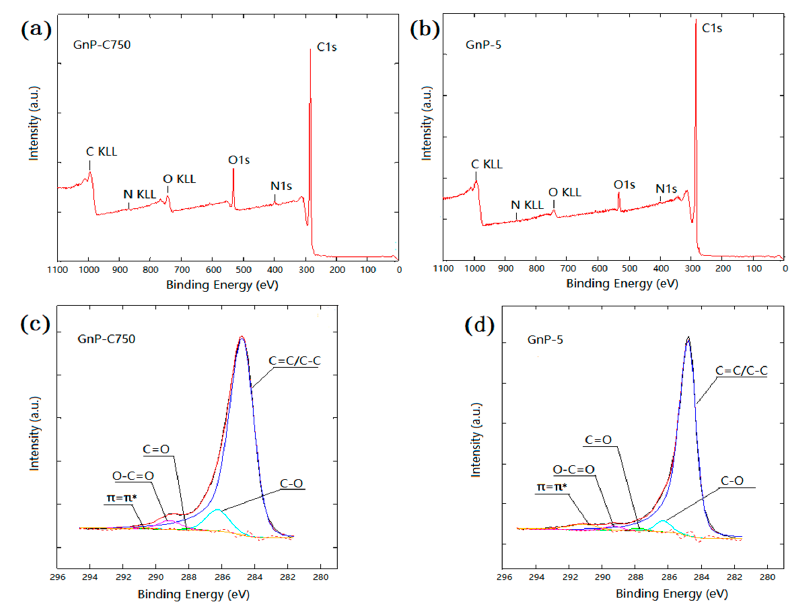
Table 1. Atomic concentration of GnPs collected from XPS results